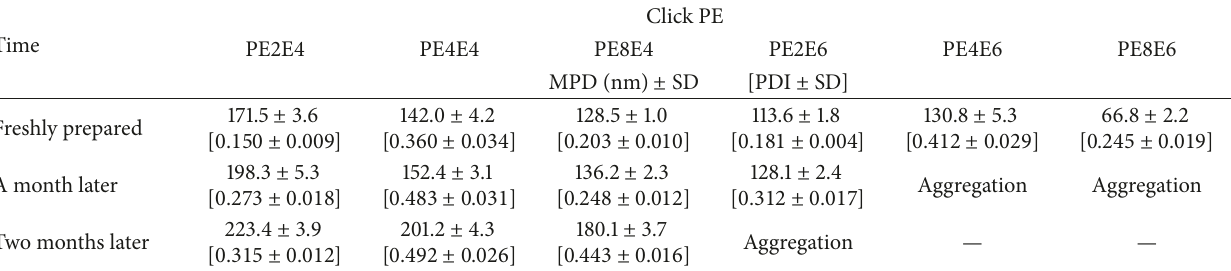
Table 15: The stability of the prepared NPs upon storage at 4-5 ∘